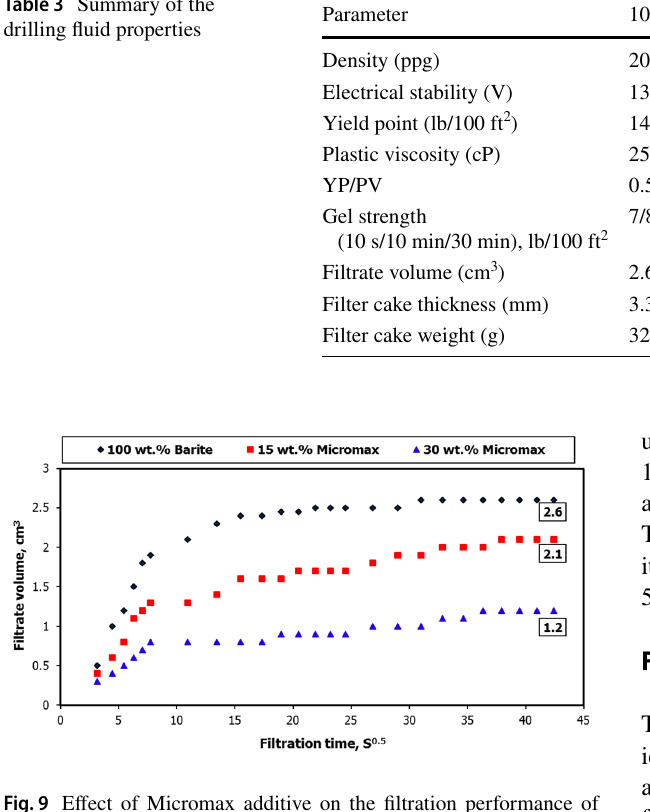
Fig. 9 Effect of Micromax additive on the filtration performance of the drilling mud (350 °F)